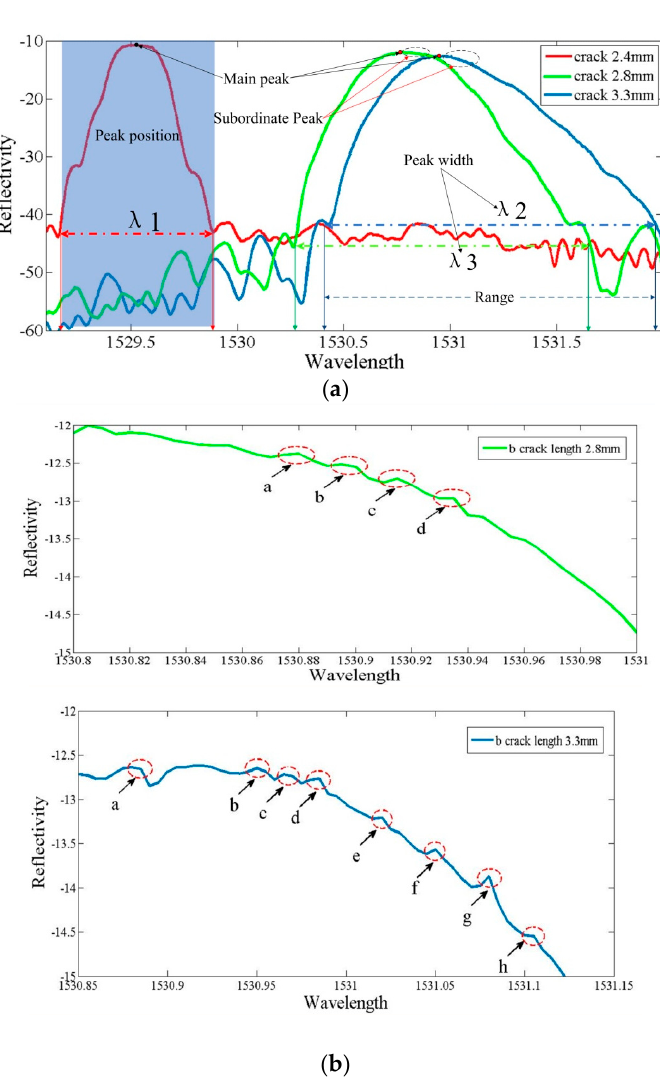
Figure 3. Variety of physical parameters with different crack lengths. ( a ) The global curve at different crack lengths; and ( b ) the subordinate peaks with a 3 db decline near the main peak.